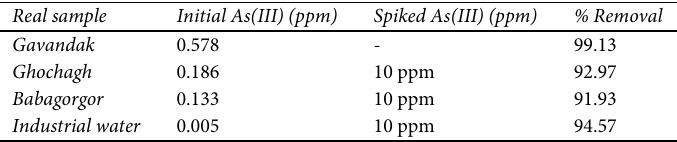
Table 2. Removal efficiency of As(III) in real samples by β -CD coated Fe 3 O 4 magnetic Table. 5. Removal efficiency of As(III) in real samples by CM-βCD-MNPs